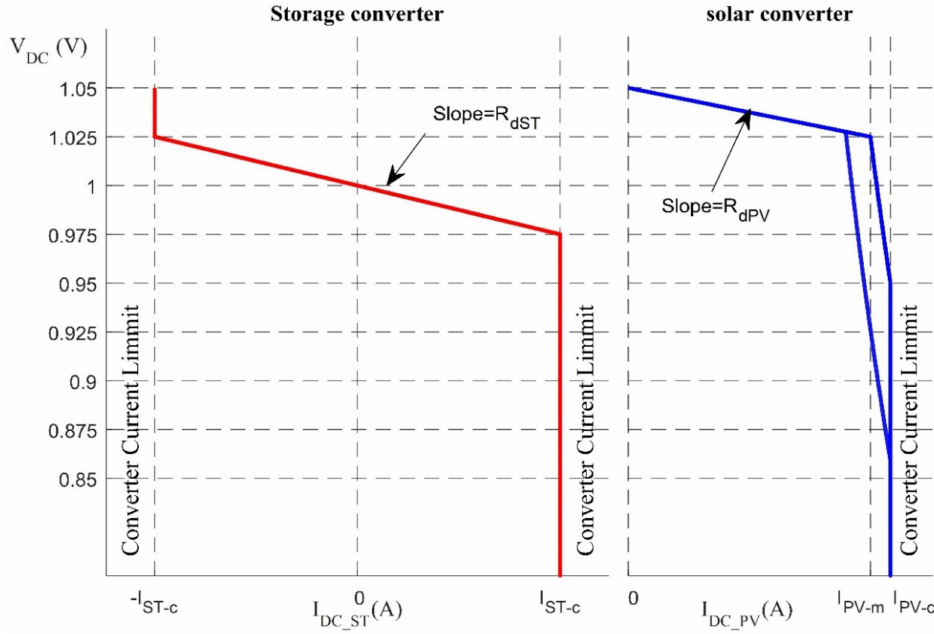
Figure 2. I vs. V curves for a DC nanogrid consisting of storage and